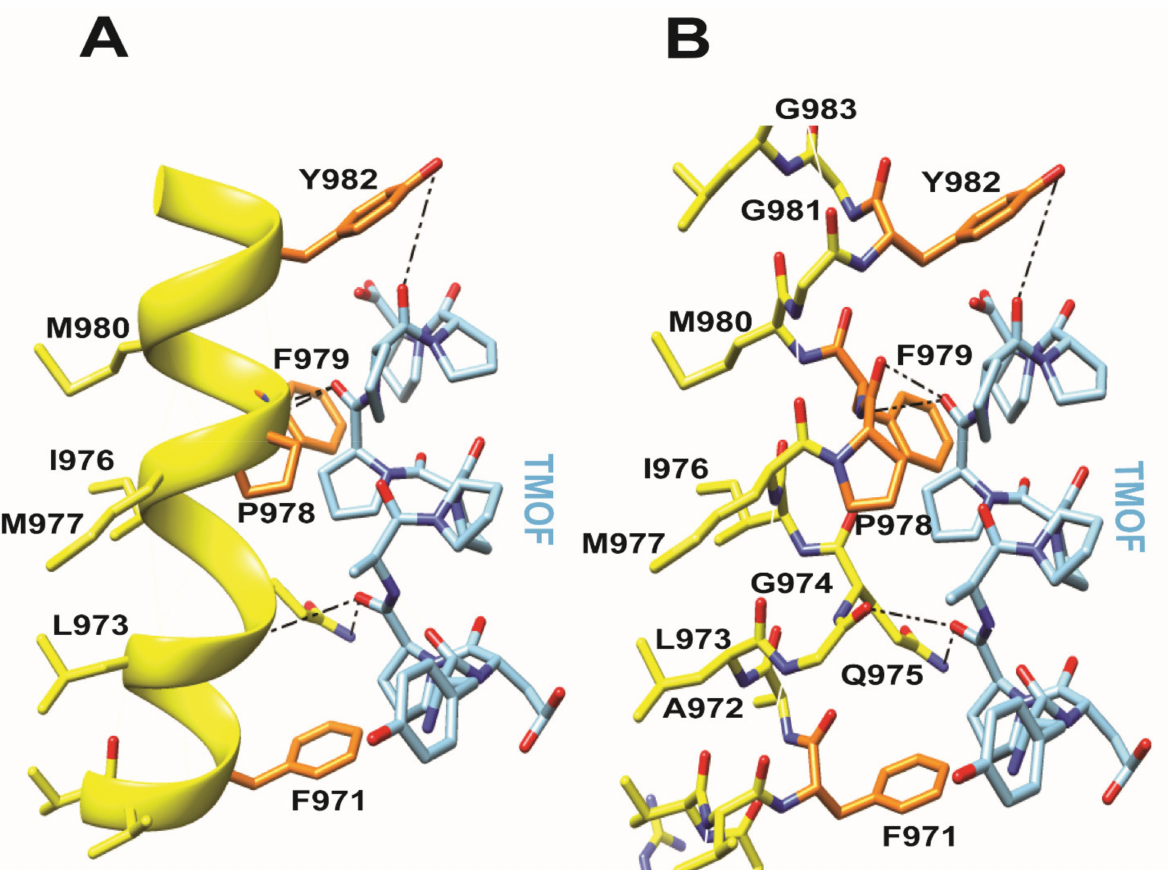
Figure 8. The interaction of Aea TMOF with the Aea ABC-TMOF receptor binding site sequence (971FALGQIMPFMGYG983) is shown in ( A ) as helical presentation (yellow color) and in ( B ) as a wireframe presentation, indicating that the binding of AeaTMOF (blue color) to its receptor involves hydrogen bonding (broken lines), hydrophobic and hydrophilic